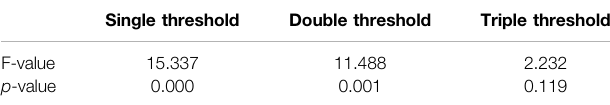
TABLE 8 | Threshold signi fi cance test. Single threshold Double threshold